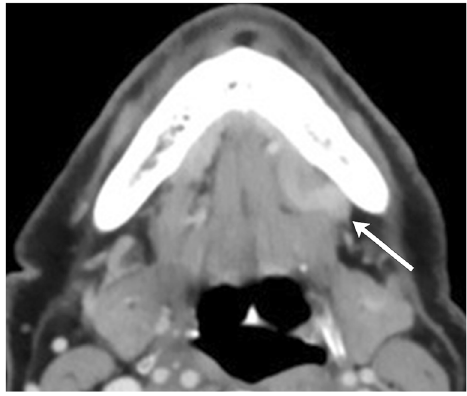
Fig. 18 Sublingual gland herniation, mimicking a palpable B lesion ^ on physical exam. Axial contrast-enhanced CT image demonstrates herniation of the left submandibular gland through a mylohyoid muscle sling